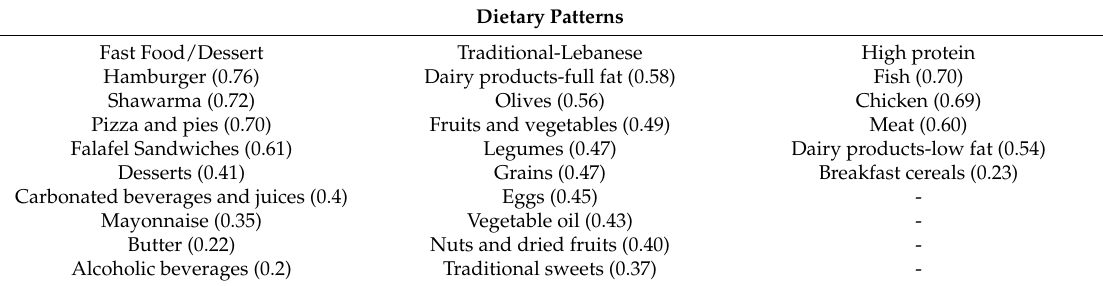
Table A1. Food items/groups constituting the dietary patterns prevalent in the study population * ,†